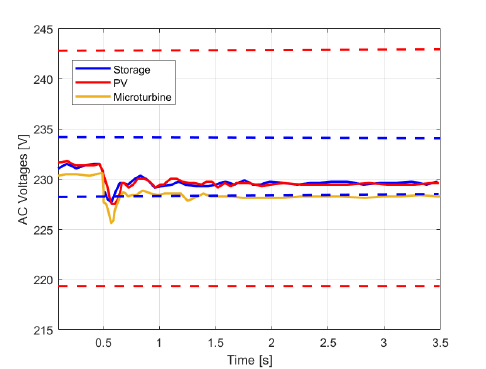
Figure 8. Simulation A: AC Voltages. The blue dashed lines represent V ac , ST , max and V ac , ST , min , while the red dashed lines represent V ac , PV , max and V ac , PV , min